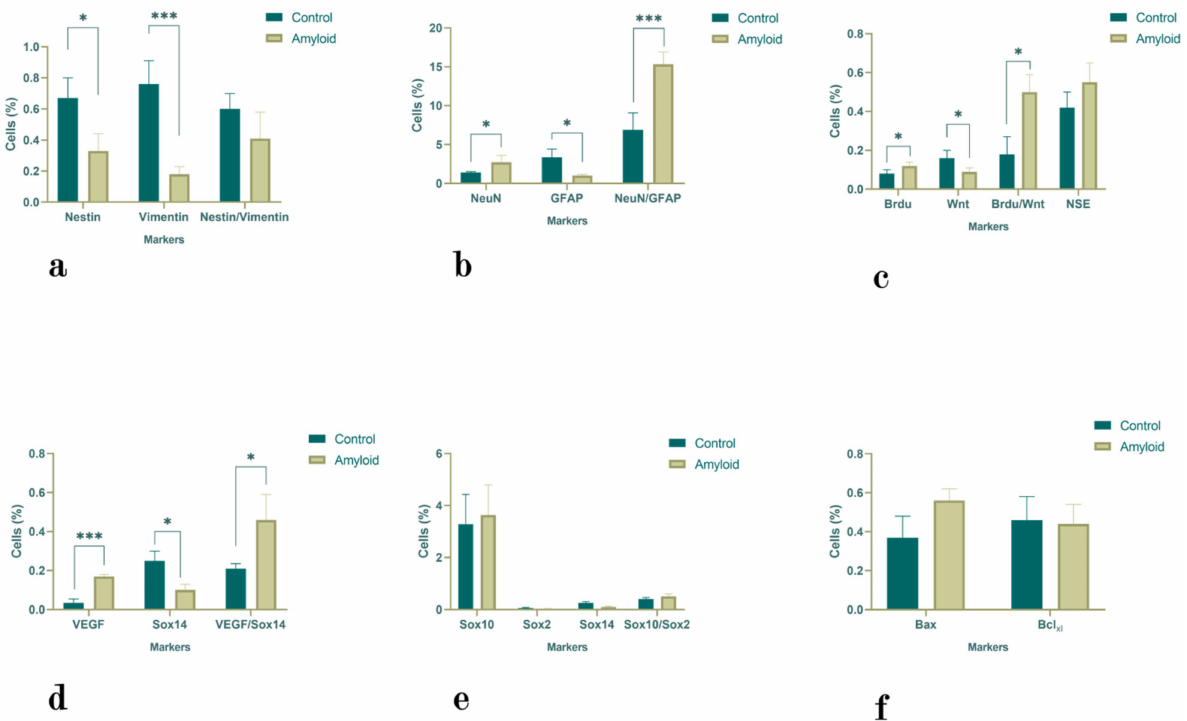
Figure 2. The proportions of Nestin-, Vimentin-, and Nestin/Vimentin- ( a ); NeuN-, GFAP-, and NeuN/GFAP- ( b ); NSE-, BrdU-, Wnt-, and BrdU/Wnt- ( c ); VEGF-, Sox14-, and VEGF/Sox14- ( d ); Sox10-, Sox2-, Sox14-, and Sox10/Sox2- ( e ); and Bax- and Bcl-xL-positive cells ( f ) in the subventricular zone under normal conditions and with A β (1-42). Statistical significance is indicated as follows: *** p < 0.0001 and * p <